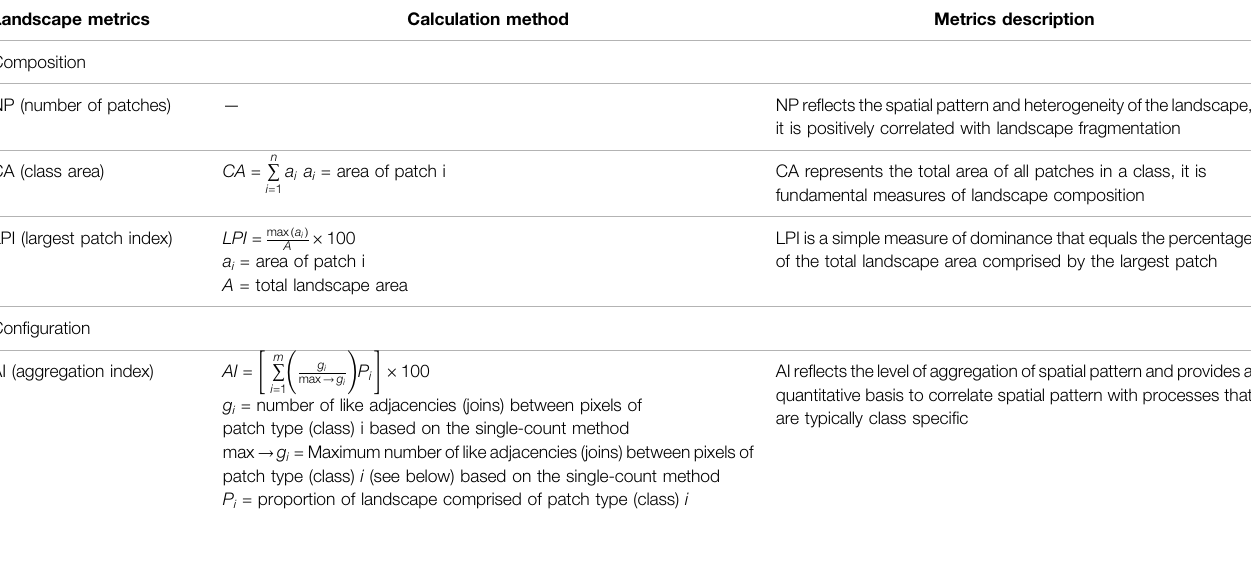
TABLE 2 | List and description of selected landscape metrics. Metrics description adapted from McGarigal et al. (2002). Landscape